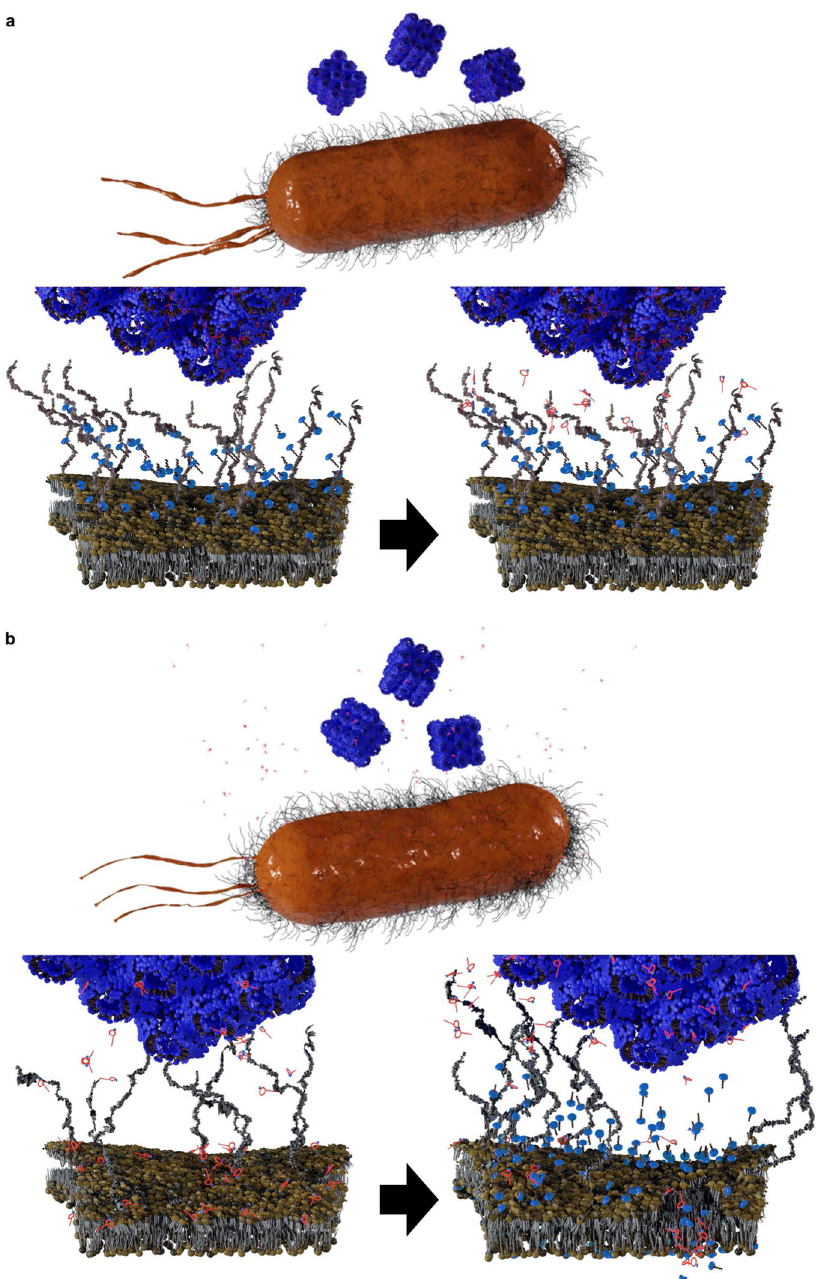
Fig. 5 A schematic illustration of the possible mechanism of action against Gram-negative bacteria. Treatment with ( a ) PMB-loaded cubosomes and ( b ) PMB combined with cubosomes. Polytherapy with PMB and cubosomes result in interactions with the bacterial OM in two consecutive ways: PMB initially interacts with the outer lea fl et of OM via electrostatic interactions, leading to destabilized areas. Cubosomes then contact with the bilayer, causing further membrane perturbations via a lipid-exchange χ = − 8 for Ia3d structure), l is the length of the lipid chain ( ca . 1.4nm for phytantriol) 54,55 . The estimated r w equations for cubosomes are given as: was then integrated into the 1D scattering function I ( Q ) and the background of Milli-Q water or PBS buffer in the capillary was subtracted by DIFFRAC.SAXS software (Monash X-ray Platform, Monash University, Australia). A silver behe- nate standard with a d spacing value of 58.38 Å was used for calibration. The cubic ffiffiffiffiffiffiffiffiffiffiffiffiffiffiffiffiffiffiffiffiffiffiffiffiffiffiffiffi (cid:3) (cid:4)q lattice parameter a was calculated as: a = d hkl h 2 þ k 2 þ l 2 , where the lattice spacing d hkl = 2 π / Q , h , k , and l are miller indices. The water channel radius of the cubic structure was estimated by r w = [( − σ /2 πχ ) 1/2 a ] − l , where σ and χ are topological constants ( σ = 1.919 and χ = − 2 for Pn3m structure; σ = 3.091 and